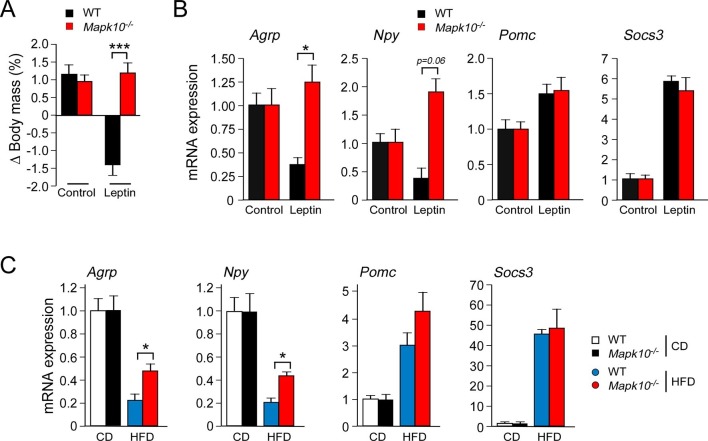
JNK3 deficiency causes a selective defect in AgRP neurons.(A) HFD-fed (4 wk) WT and Mapk10-/- mice were treated by intracerebroventricular administration of 5 µg leptin or solvent (Control). The change in body mass at 24 hr post-treatment was measured (mean ± SEM; n=10~12; ***p<0.001). (B) WT and Mapk10-/- mice were treated without or with leptin (2h) prior to measurement of hypothalamic gene expression by Taqman© assays (mean ± SEM; n=10~12; *p<0.05). (C) Hypothalamic gene expression in CD-fed and HFD-fed (12 wk) WT and Mapk10-/- mice was measured by Taqman© assay (mean ± SEM; n=10~12; *p<0.05).